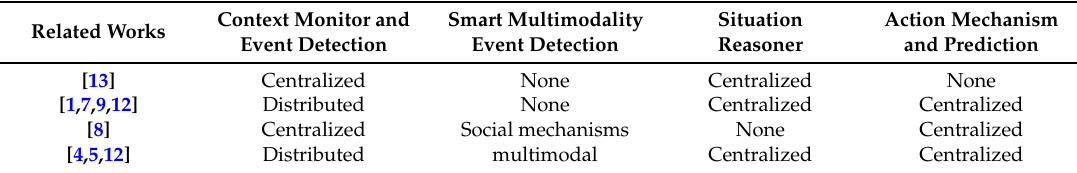
Table 1. Related works’